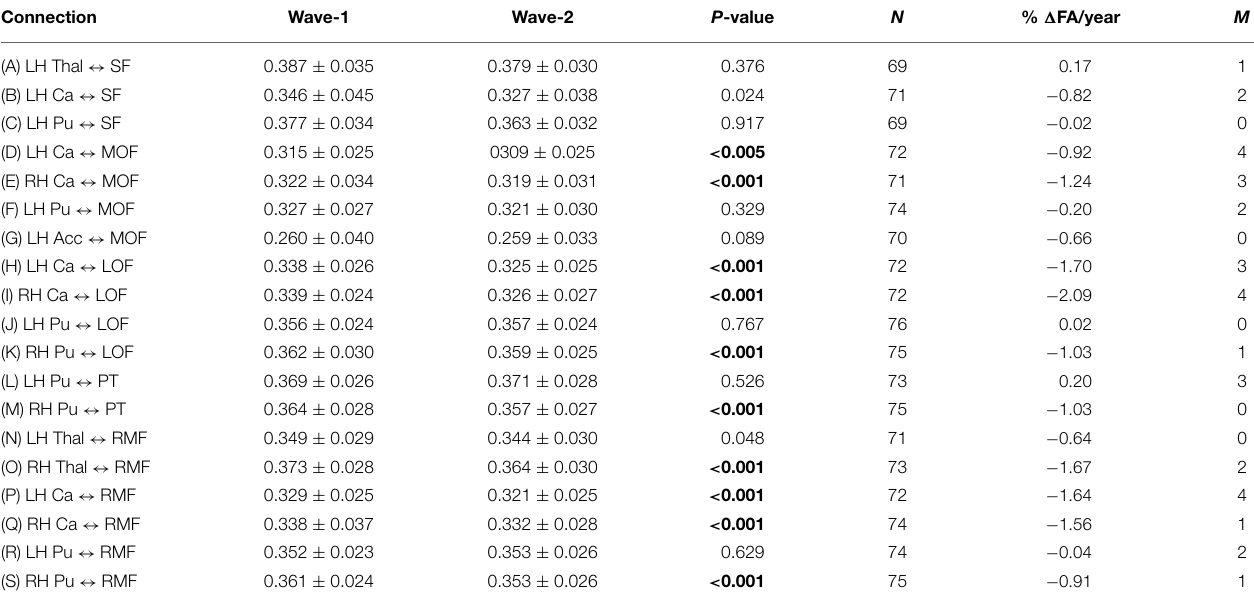
The percentage annual change of mean FA (calculated first for each subject and then averaged across the total sample) is given in column 6. N ( ≤ 76 ; column 5) denotes the total number of subjects for which the specific fiber bundle could be identified according to the given criteria. M (column 7) denotes the number of participants discarded by the